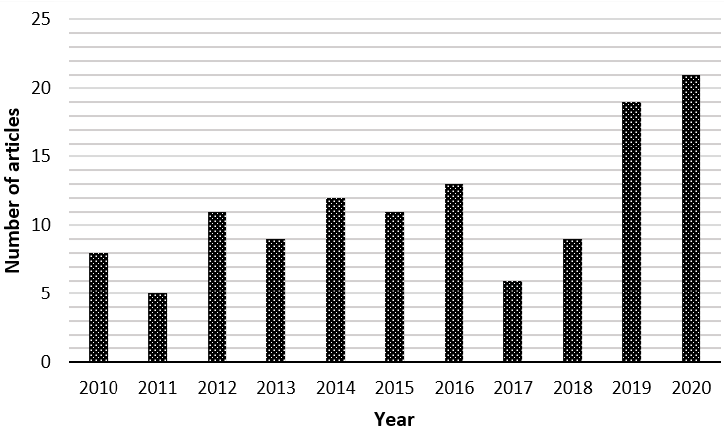
Figure 4. Number of articles per year. Only articles published prior to 31 October 2020 are counted.